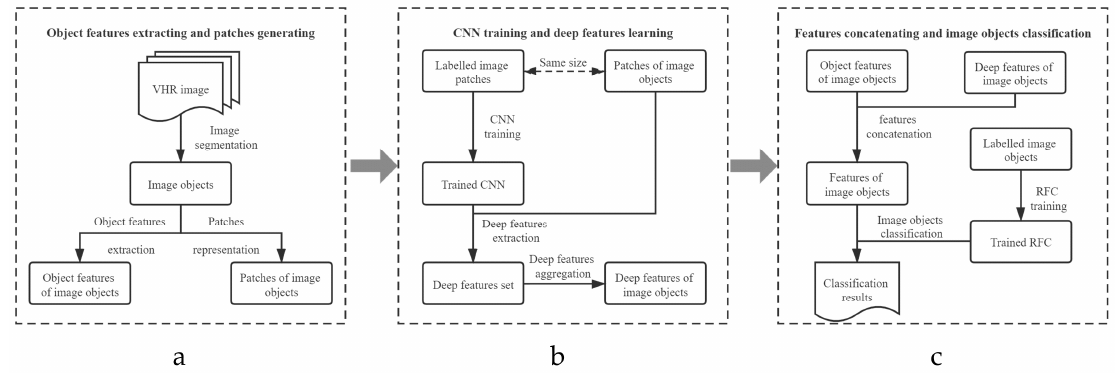
Figure 1. The framework of the proposed approach. ( a ) Object features extracting and patches generating, ( b ) CNN training and deep features learning, ( c ) features concatenating and image objects classification.